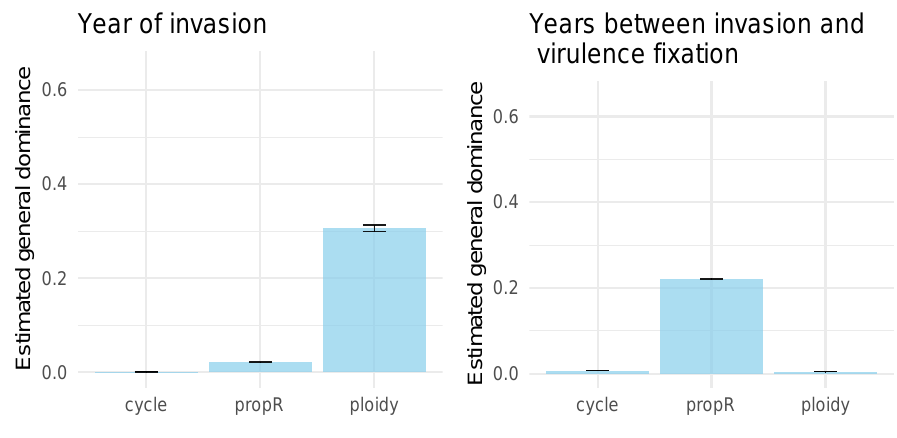
Figure S3 – Estimated general dominance of each predictor calculated from general linear models applied to two output variables of the restricted simulation design: the year of invasion and the time elapsed between the invasion and the fixation of the avr allele. For each predictor the general dominance was estimated from bootstrap average values with the corresponding standard error for 100 bootstrap